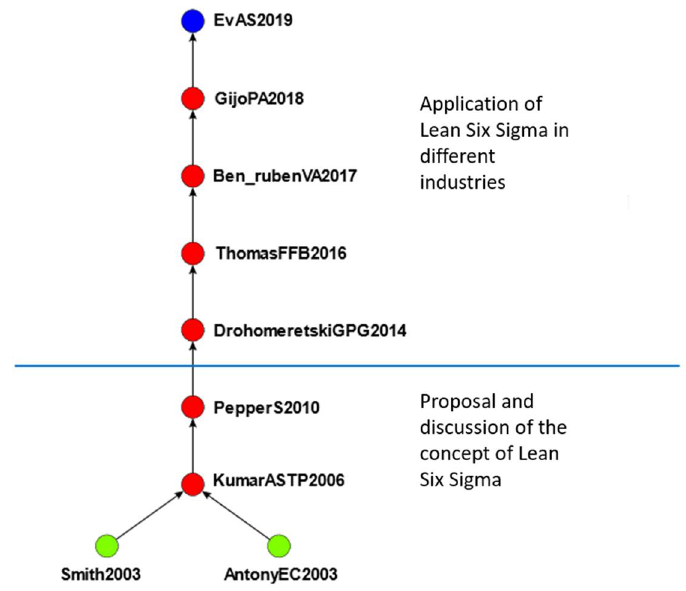
Figure 7. The main path of the second group.